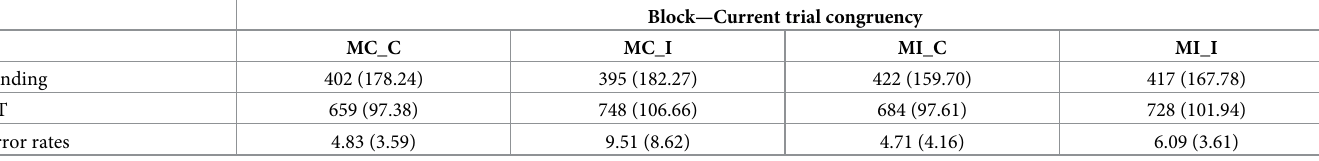
Table 3. Means (SD) for intentional binding (in ms), RTs (in ms) and error rates (in %) in relation to block and current congruency (block